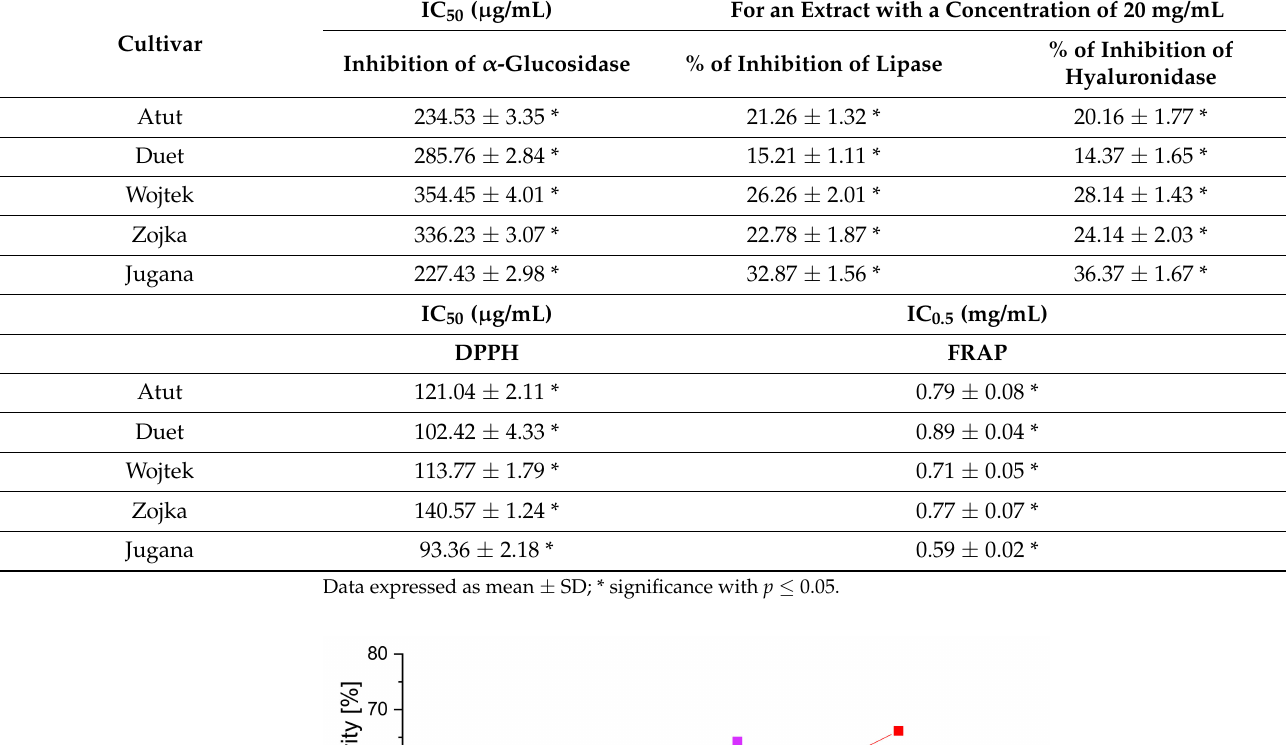
Table 4. In vitro activity of haskap berry leaves water extracts.